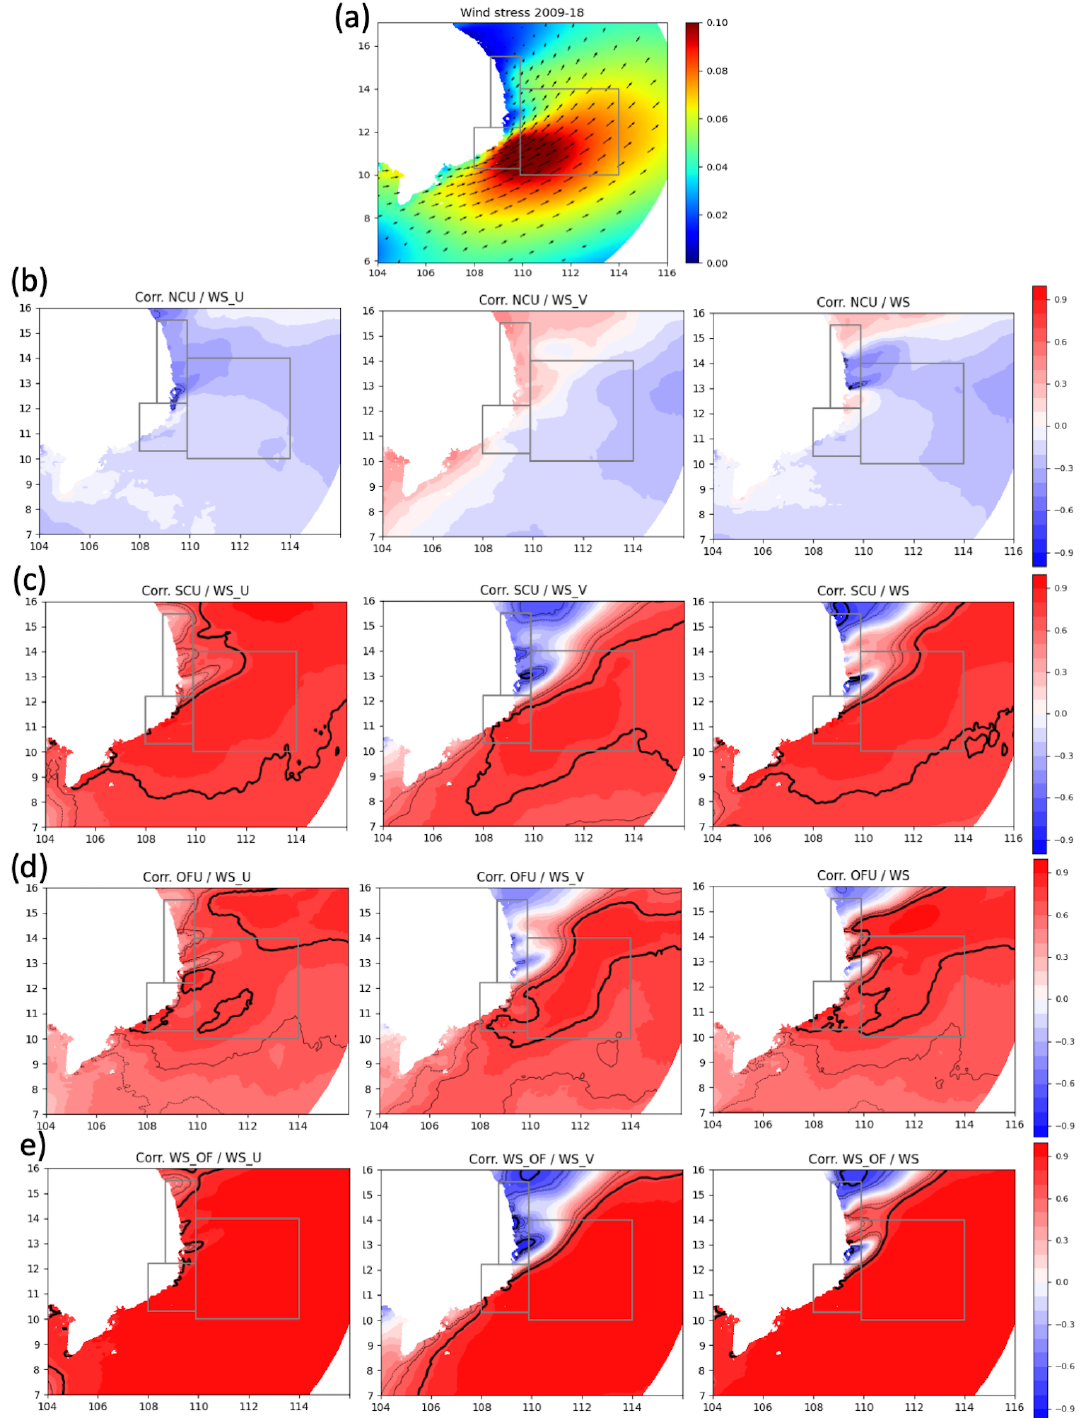
Figure 16. (a) Direction (arrows) and intensity (Nm − 2 ) of average JJAS wind stress over the SVU area during 2009–2018 from ECMWF analysis. Panels (b) to (e) : correlation between yearly time series of the zonal (left) and meridional (middle) components of wind stress and of its intensity (right) and (b) UI y, NC , (c) UI y, SC , (d) UI y, OF , and (e) JJAS wind stress intensity over BoxOF. Thick, plain, and dotted lines correspond, respectively, to the isolines p = 0.01, p = 0.05, and p = 0.10.